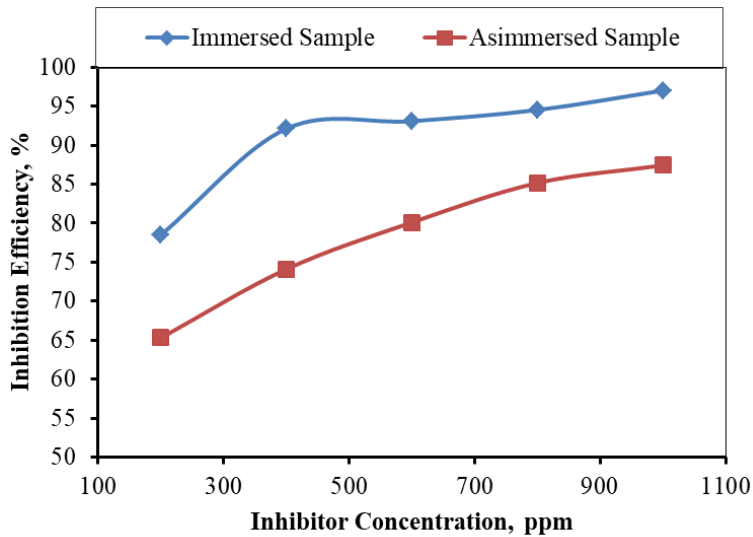
Figure 9. The inhibition efficiency of the inhibitor obtained from the polarization of both immersed and as-immersed MS samples in different concentrations of inhibitor.